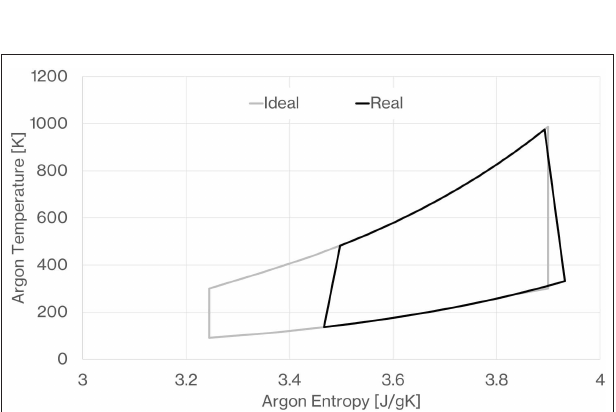
FIGURE 24 | Temperature-Entropy diagram of the simulated charge cycle showing the effect of the calculated irreversible losses as compared to the ideal cycle.